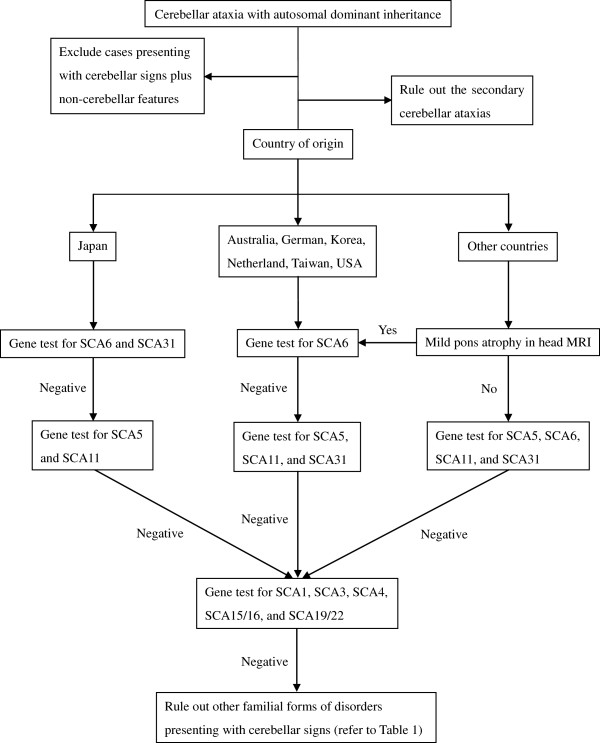
This flowchart explains diagnostic algorithm for ADCA Type III. After excluding the cases presenting with cerebellar signs plus non-cerebellar features and secondary cerebellar ataxias, we suggest the appropriate genetic testing based on geographic distribution (patient’s country of origin). If the genetic tests are negative for known ADCA Type III gene mutations, we suggest to perform genetic testing for subtypes of ADCA Type I, which could possibly present with pure cerebellar syndrome at the early stage of illness. After excluding these diseases, other familial forms of disorders presenting with cerebellar signs should be considered. ADCA: autosomal dominant cerebellar ataxia; MRI: magnetic resonance imaging; SCA: spinocerebellar ataxia; USA: the United States of America.